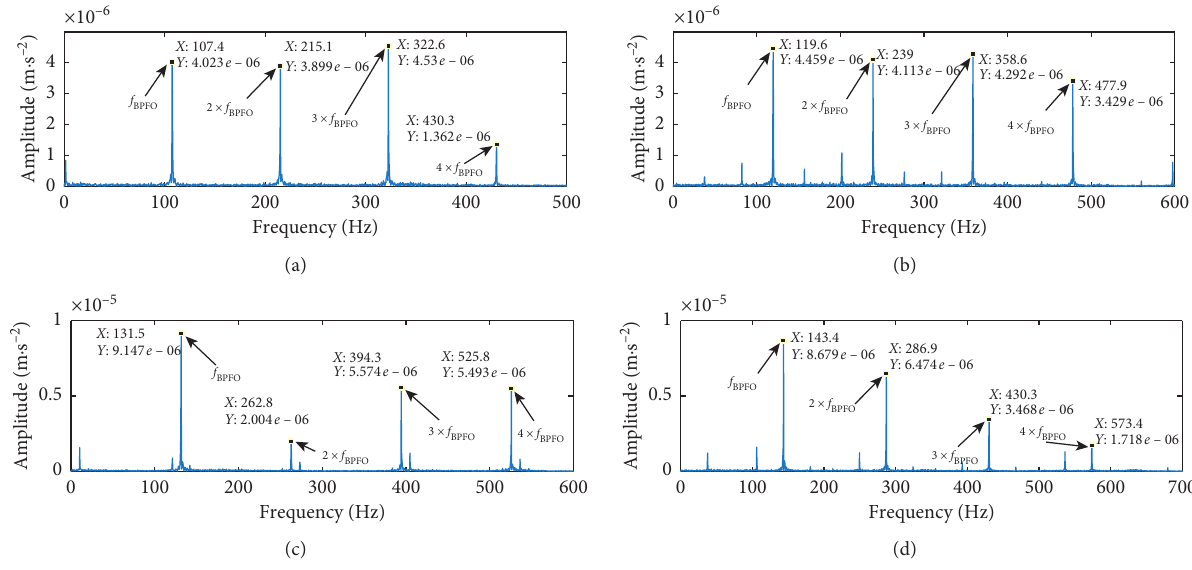
Figure 22: Simulated signals in frequency domain under different rotation speeds when load is 1500N and defect size is 0.014 inches: (a) 1800rpm, (b) 2000rpm, (c) 2200rpm, and (d) 2400rpm.